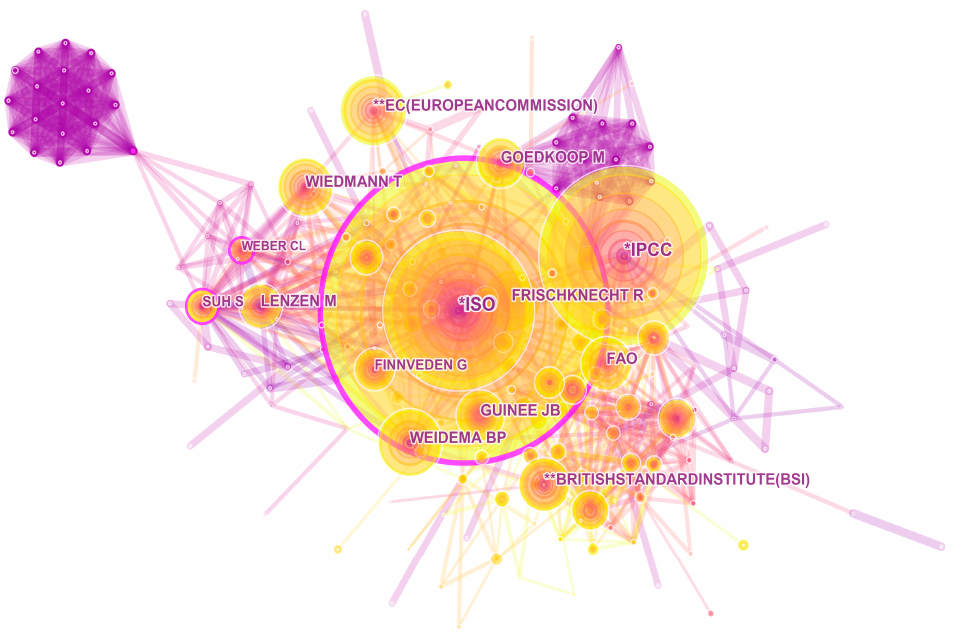
Processes 2019 , 7 , x FOR PEER REVIEW